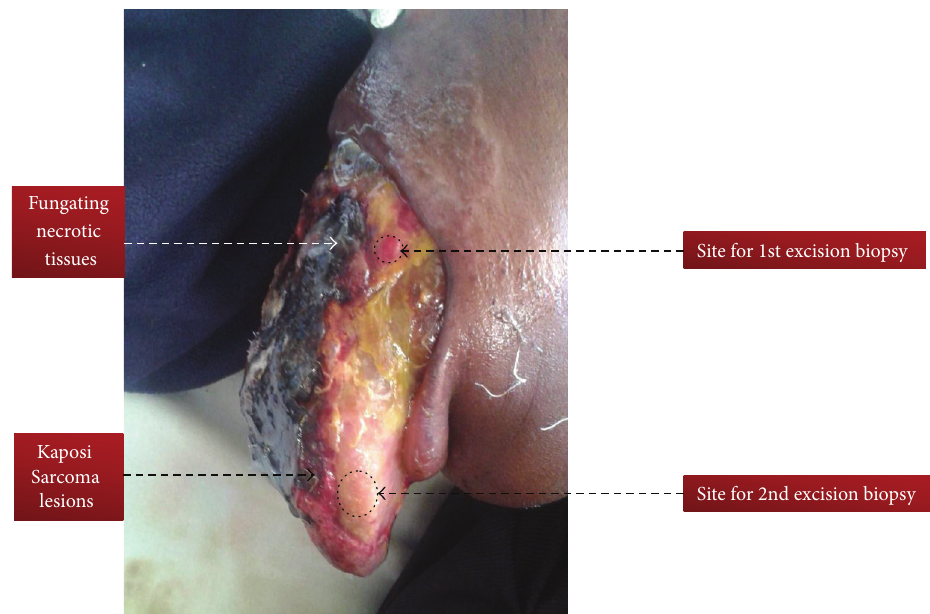
Figure 1: Enlarged and fungating tongue completely occluding oral cavity as a result of infiltrating Kaposi Sarcoma in HIV positive Maasai